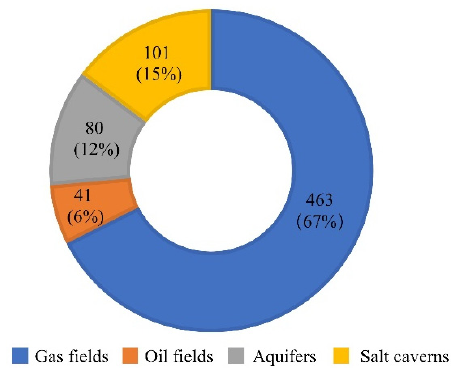
Figure 1. The number of various types of UGS and their proportions in global UGS Reprinted/adapted with permission from Ref. [20]. Copyright 2021, Elsevier Ltd.